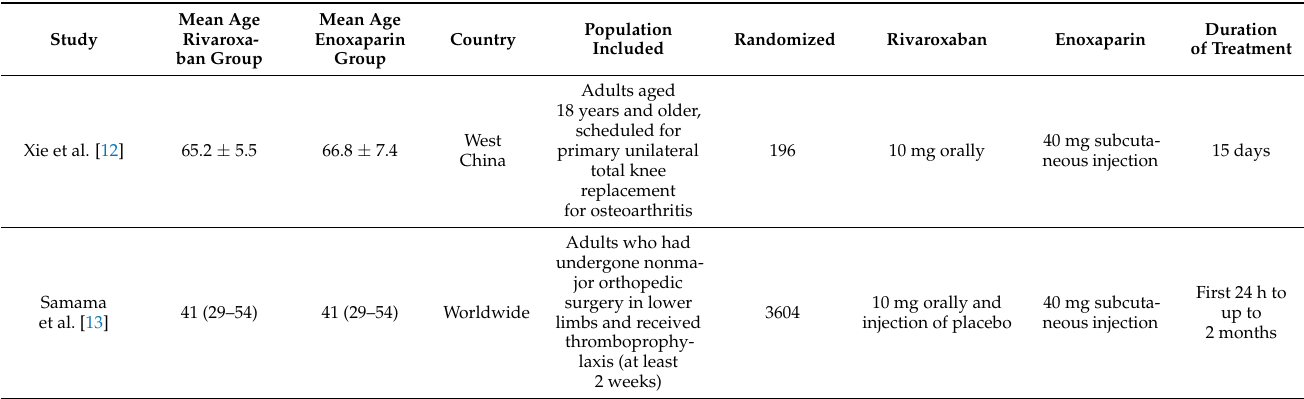
Table 2. Summary of included